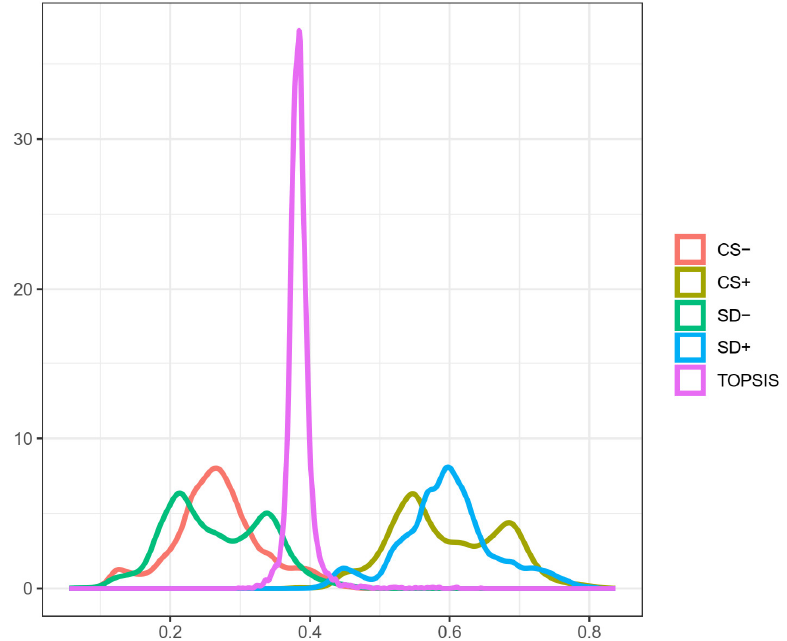
Figure 6. Density plot comparison for UP-IS performance under alternative weights.